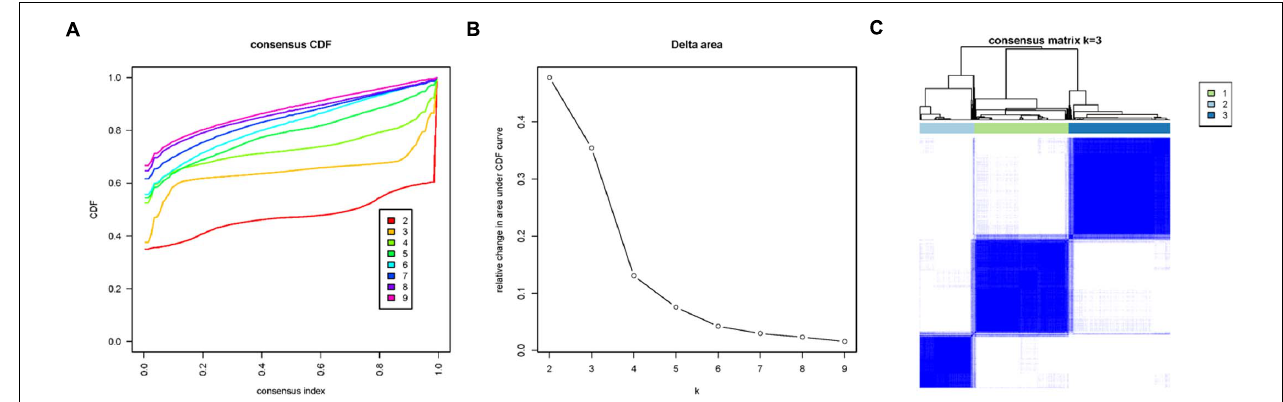
FIGURE 2 | Consensus clustering analysis of LUAD tissue samples in TCGA-LUAD according to immune infiltration degree. (A) Consensus clustering cumulative distribution function (CDF) diagram with a tissue clustering number from k = 2 to k = 9. (B) Delta area plot of consensus clustering analysis of LUAD tissue, and the relative changes in CDF AUC in different k -values compared with that in k -1. k -value was finally chosen as 3, combining a series of analysis results. (C) Heatmap of sample consensus after